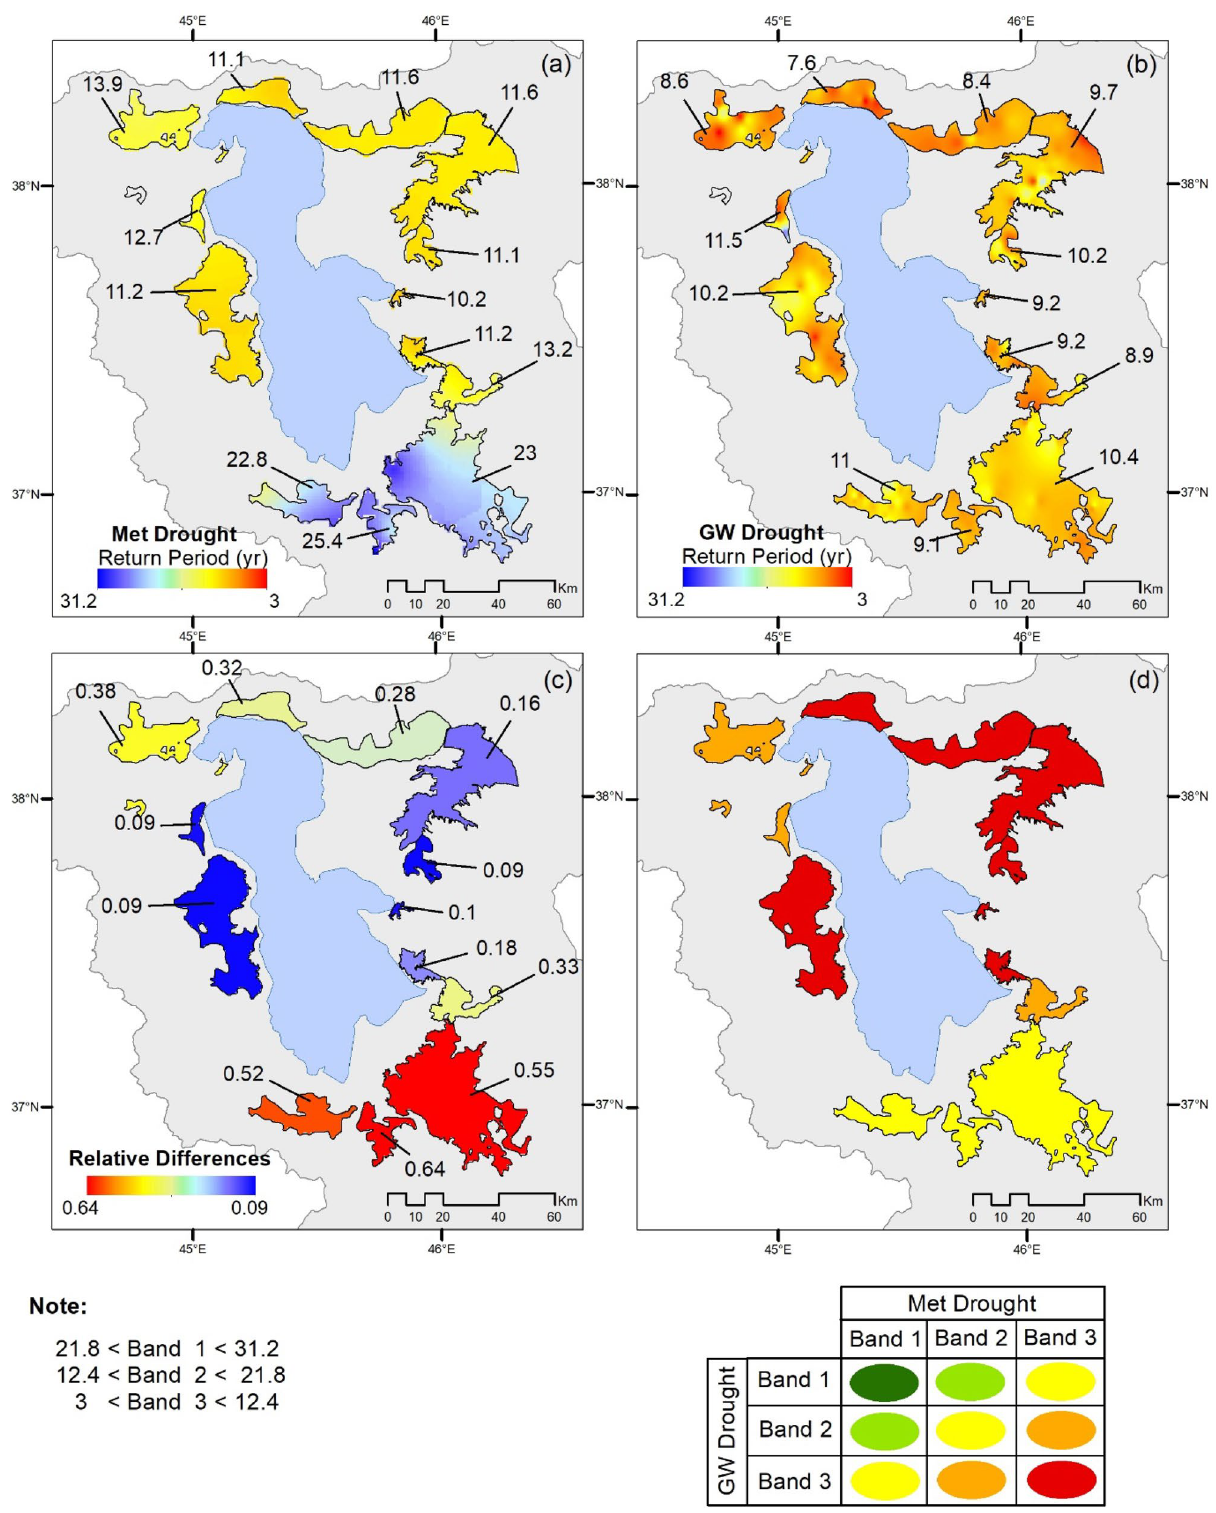
Figure 5. Variations in drought return periods between aquifers: ( a ) meteorological drought; ( b ) groundwater drought; ( c ) relative differences; ( d ) risk matrix derived for each aquifer based on return periods of Met/GW droughts. Note: The figure is produced by the authors using QGIS 3.01 v